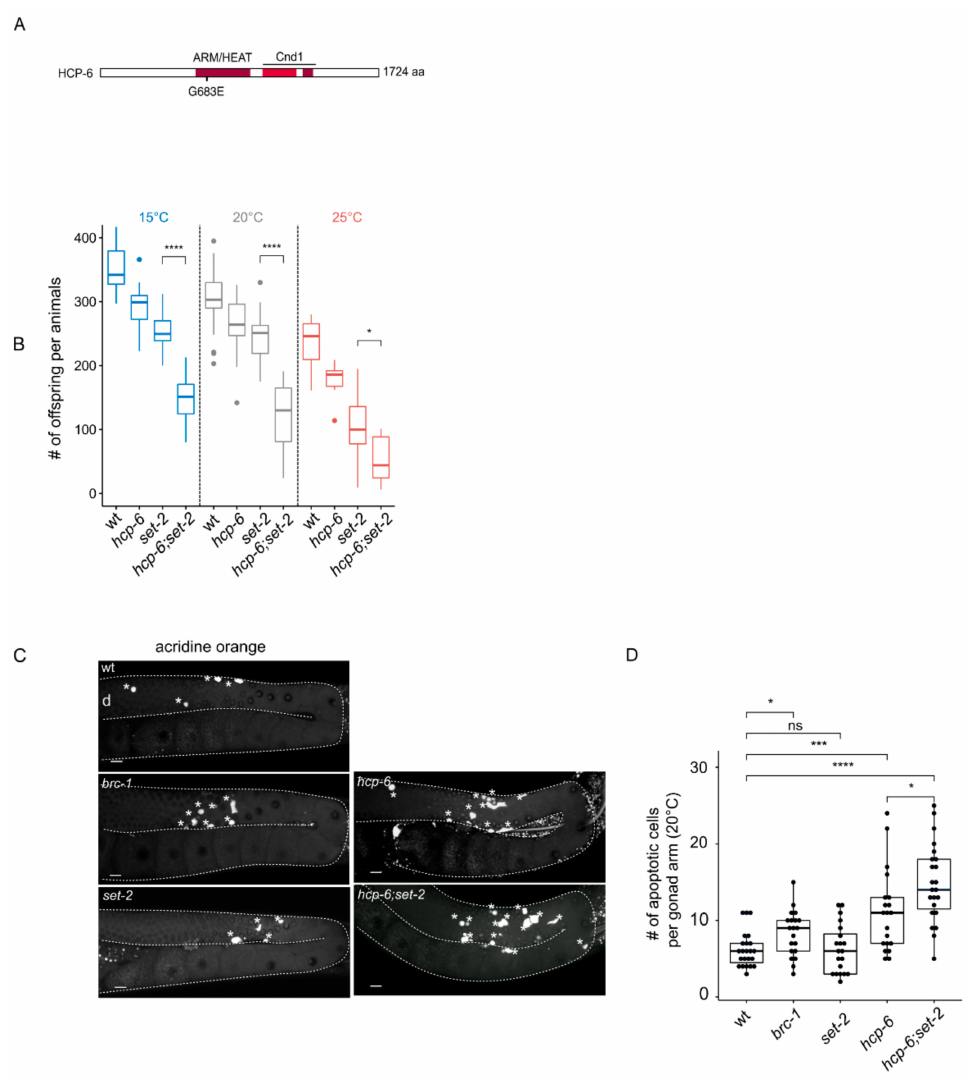
Figure 3. Enhancement of hcp-6(mr17) phenotypes in set-2(bn129) mutant animals. ( A ) Schematic diagram of HCP-6 protein and position of the mr17 mutation. Conserved ARM / HEAT and Cnd1 (Condensin complex subunit 1) domains are highlighted in red. ( B ) Brood size per animals at indicated temperatures (15 ◦ C, 20 ◦ C, 25 ◦ C), (n = 11 animals per genotypes at 15 ◦ C and 25 ◦ C, and 33 at 20 ◦ C). [***] p < 0.001, [*] p < 0.05 ( t -test adjusted for multiple comparison with the Bonferroni method). ( C ) Representative confocal images of germlines stained by acridine orange. Asterisks indicate apoptotic cells, (d) indicates distal region; orientation is the same for all gonads. ( D ) quantification of the number of apoptotic cells in the germline of animals switched at 20 ◦ C for 24 h (n > 20 gonads per genotypes). A Wilcoxon test was performed after a significant di ff erence with a Kruskal Wallis test, [ns] non significative di ff erence, * p < 0.05, *** p < 0.001, **** p <